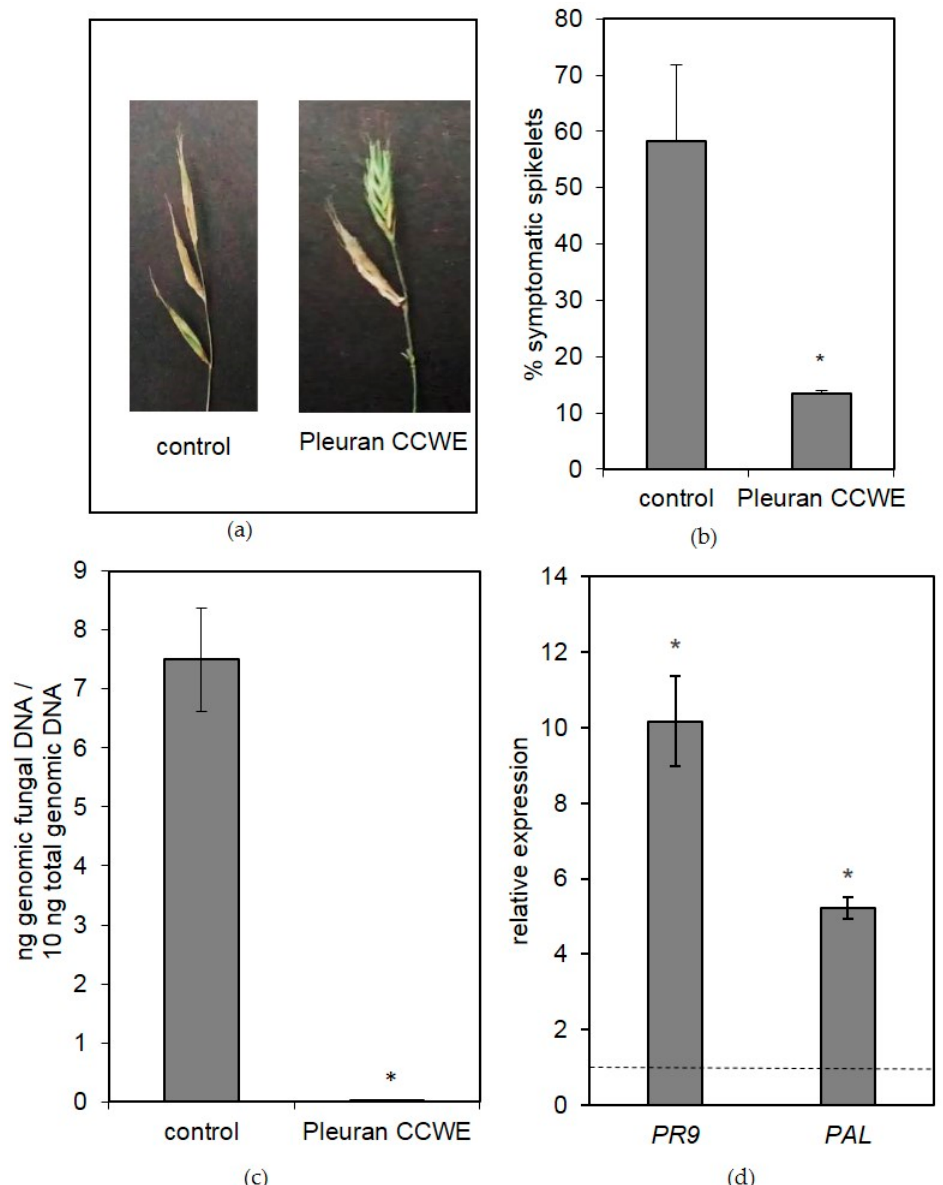
Figure 5. B. distachyon responses to a Pleuran complex cell wall extract (CCWE) pre-treatment before inoculation with Fusarium graminearum. ( a ) and ( b ): symptoms observed on spikelets (10 days post-inoculation) ( c ) Quantification of fungal biomass in plants determined by quantitative polymerase chain reaction (PCR) ( d ) Relative expression levels of Phenylalanine-Ammonia-Lyase ( PAL ) and peroxidase ( PR9 ) genes in B. distachyon leaves 48 h post-inoculation with Fusarium graminearum for plants pre-treated with Pleuran CCWE related to the control (not treated; dotted line). Each value is the mean of two replicates (ten plants per replicate) and vertical bars are standard deviation. * means significant difference with control ( p < 0.05).